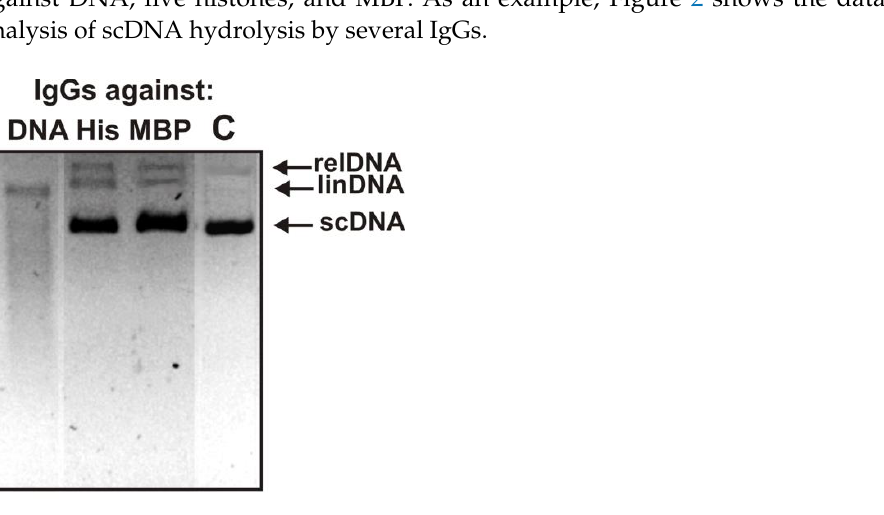
Figure 1. SDS-PAGE analysis hydrolysis of five histones (H1 – H4) by IgGs-abzymes against these five histones (lane a-H) as well as MBP (lane a-M) ( A ) and human myelin basic protein by IgGs against five histones (lane a-H) and Abs-abzymes against MBP (lane a-M) ( B ). MBP and a mixture of five histones with and without IgGs (0.03 mg/mL) were incubated for 12 h. Lane C corresponds to the histones ( A ) and MBP ( B ) incubated without IgGs. Lane K — proteins with known molecular masses ( A , B ).